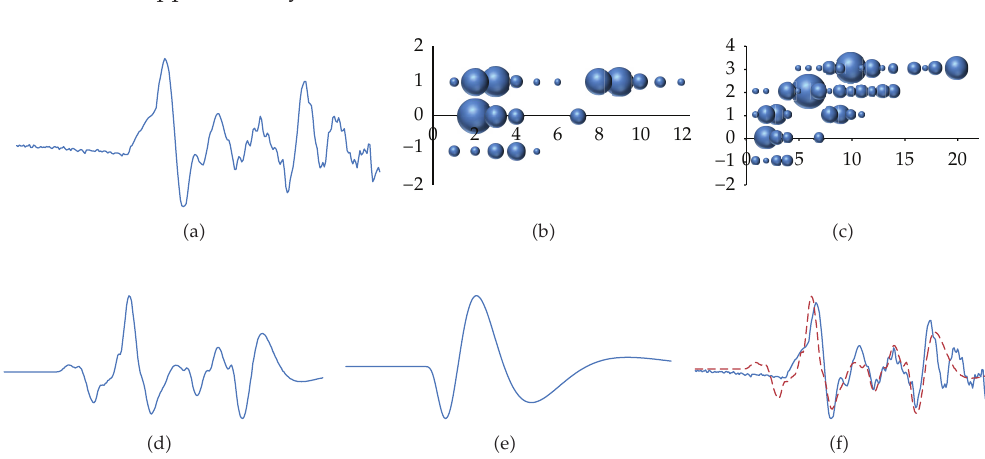
; (cid:2) d (cid:3) K q (cid:2) t (cid:3) wavelet j (cid:5) − 1